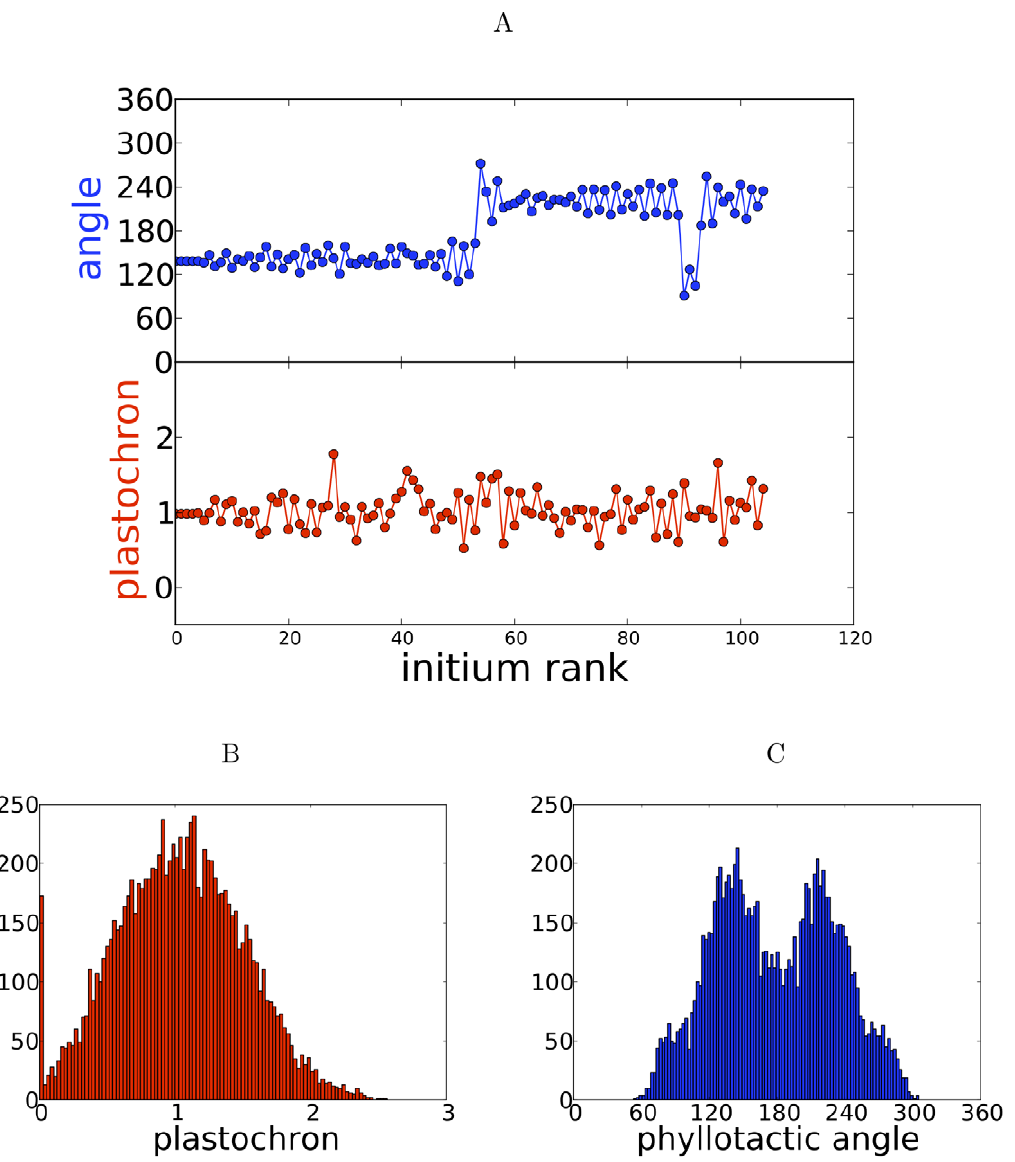
Figure 3. The model with noise on the size of the competent circle. (A) A typical sequence of angles and plastochrons; the simulation is started with no noise; one handedness reversal is clearly visible. (B) Histograms of plastochrons. (C) Histogram of divergence angles ( N ~ 10200 ) showing peaks corresponding to either handedness: ^ 137 0 and 223 0 . Simulation parameters: steepness of inhibition gradient a ~ 2 , C ~ 1 : 92 , threshold for initiation E ~ 1 , noise strength s R = R ~ 0 : 3 .